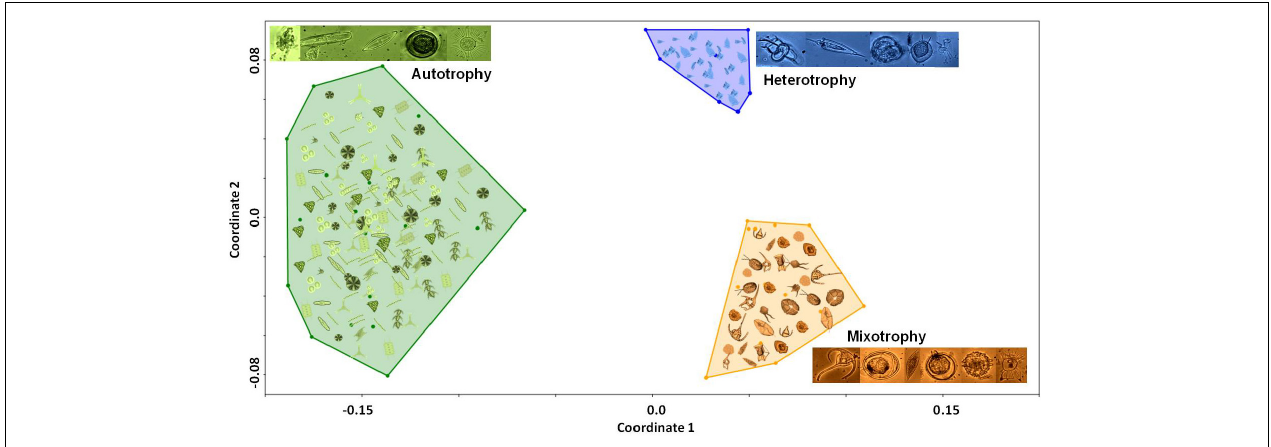
FIGURE 5 | NMDS diagram from the functional traits of microphytoplankton in the eddies, using multidimensional indices based on Euclidean distance and non-parametric multidimensional scaling of traits. These metrics were calculated using the dbFD function of the FD package (Laliberté and Legendre, 2010) (R software, version 3.5.1; R Core Team,